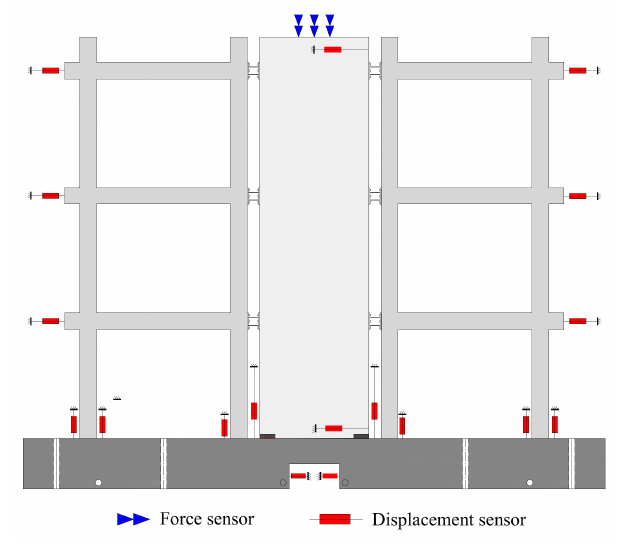
Figure 5. Instrumentation (PFRW shown).